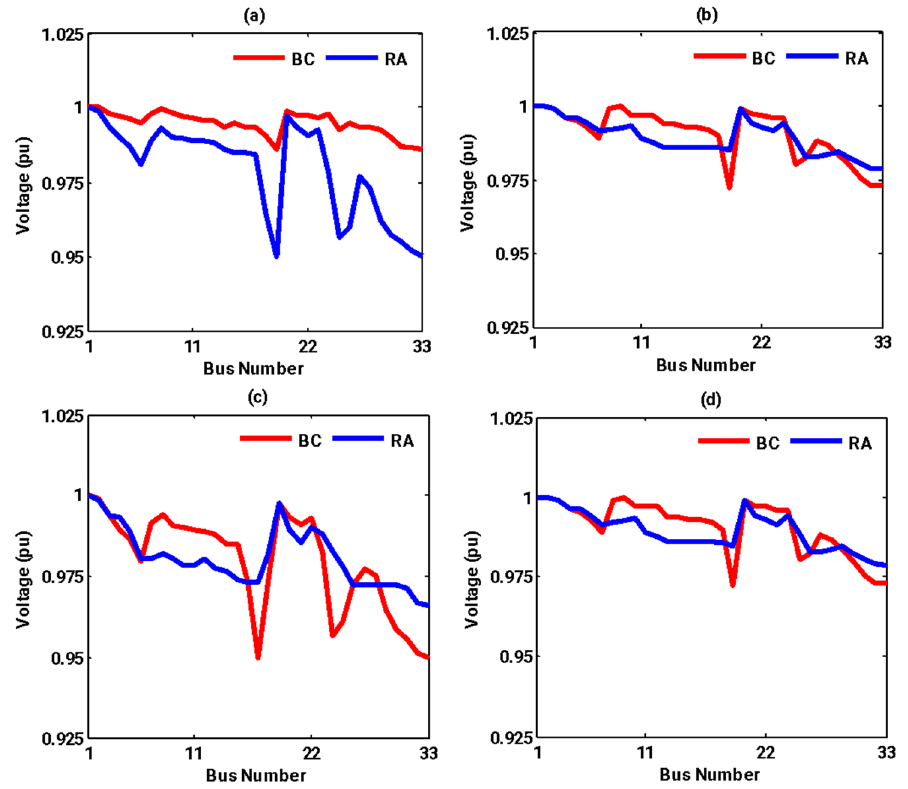
Figure 9. Voltage profile of the MG in BC and RA case studies (on-grid): ( a ) interval T1; ( b ) interval T2; ( c ) interval T3; ( d ) interval T4.